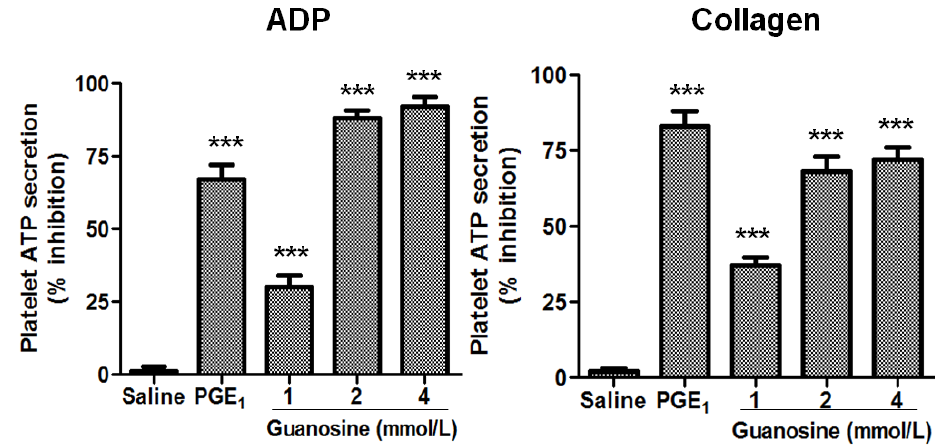
Figure 3. Guanosine concentration-dependently inhibited platelet aggregation. Quantitation of the inhibitory effect of guanosine on platelet aggregation induced by ADP (8 µmol/L) and collagen (1.5 μ g/mL). Saline (negative control) and PGE control). Results were expressed as % inhibition (mean ± SEM, n =